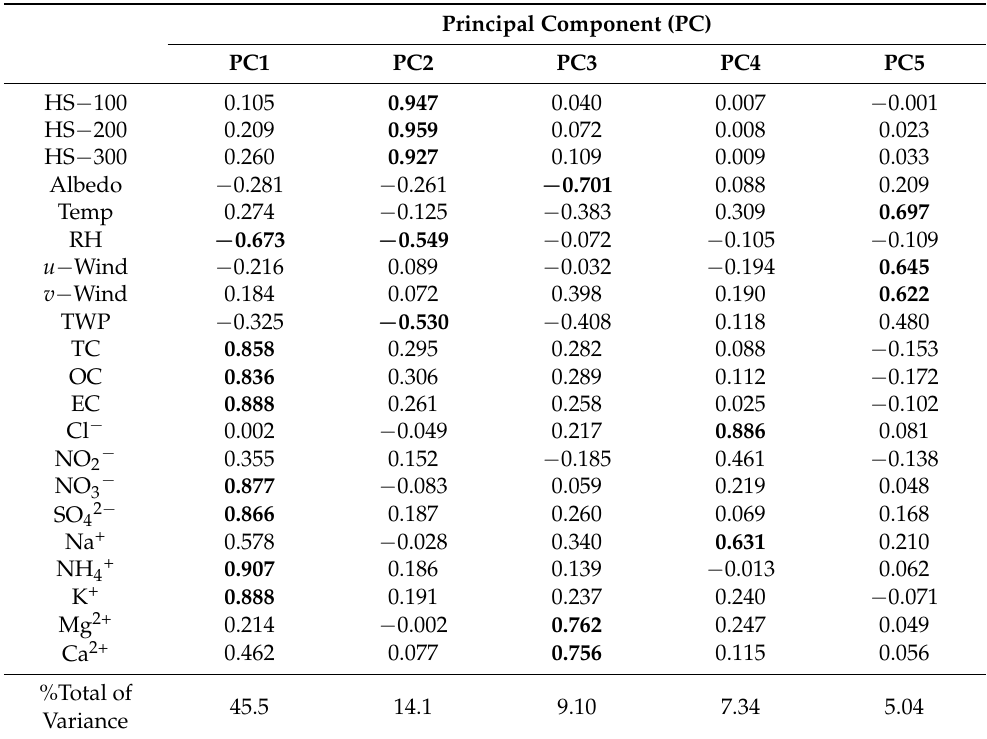
Table 5. Principal component analysis of the meteorological parameters and chemical species in PM 2.5 obtained from this study.